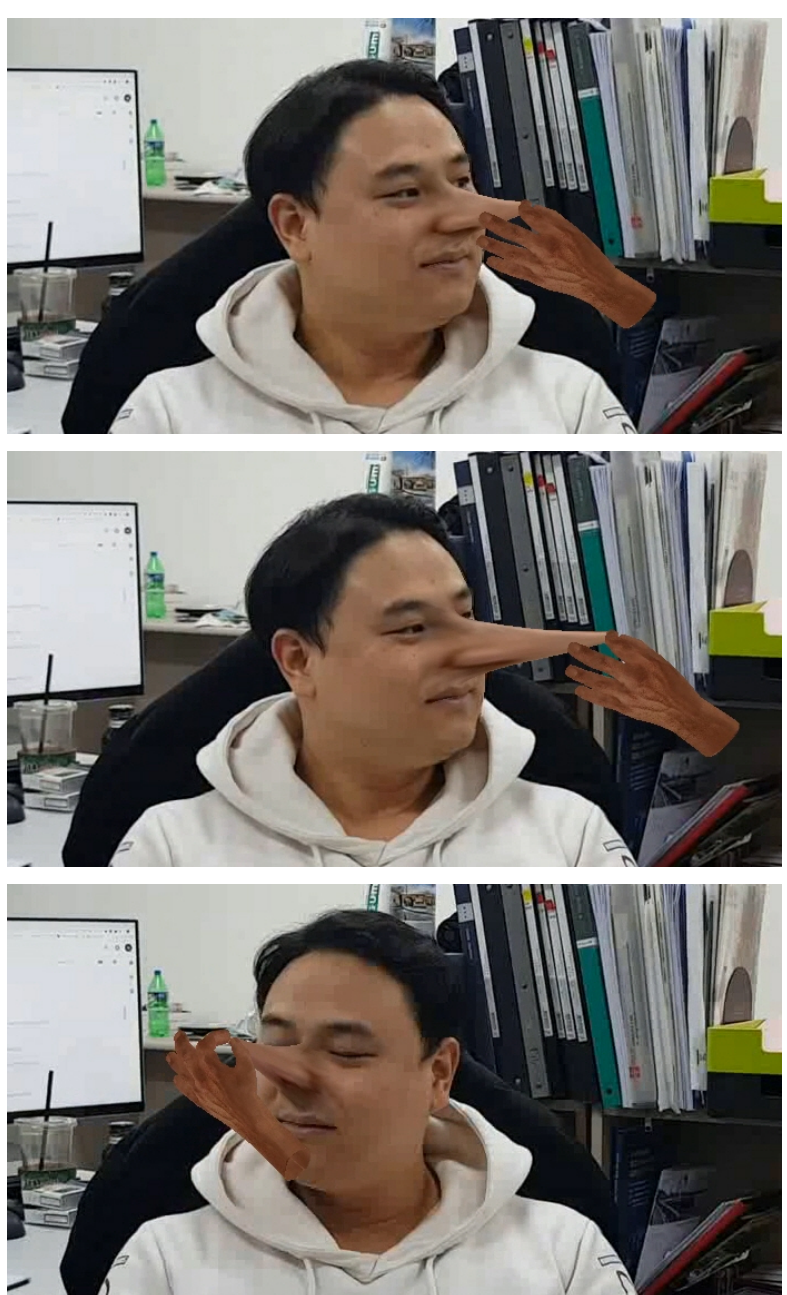
Figure 7. An example of augmented reality application using the proposed